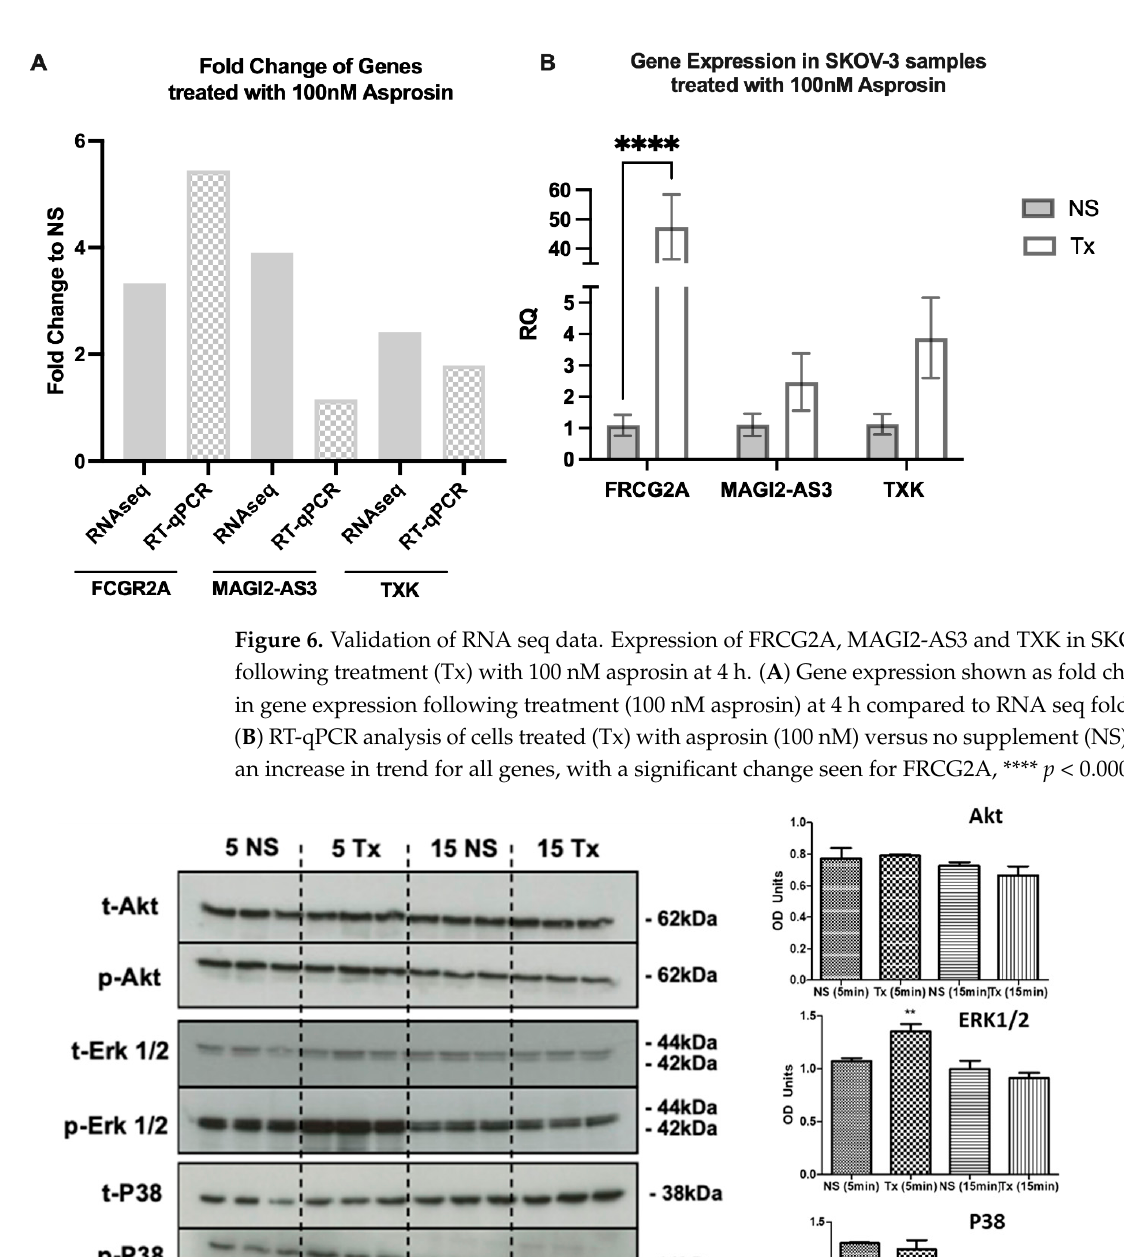
Figure 6. Validation of RNA seq data. Expression of FRCG2A, MAGI2-AS3 and TXK in SKOV-3 cells following treatment (Tx) with 100 nM asprosin at 4 h. ( A ) Gene expression shown as fold change (FC) in gene expression following treatment (100 nM asprosin) at 4 h compared to RNA seq fold increase. ( B ) RT-qPCR analysis of cells treated (Tx) with asprosin (100 nM) versus no supple- ment (NS) showing an increase in trend for all genes, with a significant change seen for FRCG2A, **** p < 0.0001.